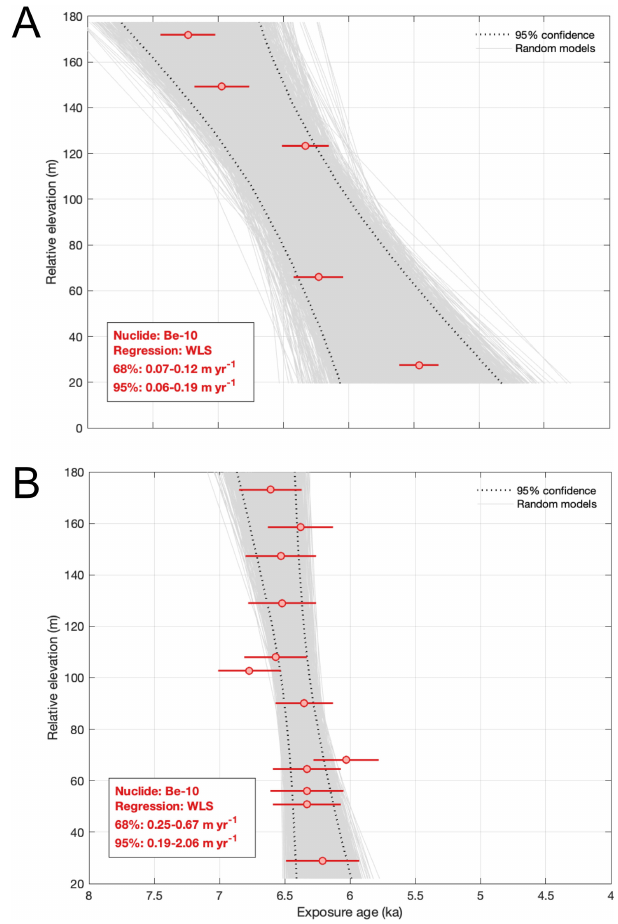
Figure 7. Linear thinning rates derived from relative elevation, above the ice, and mid-Holocene exposure ages estimated using http://ice-tea.org/en/ from Jones et al. (2019) for (a) Mt Kring Holocene samples and (b) Hughes Bluff samples with outliers iden- tified and omitted using outlier detection in